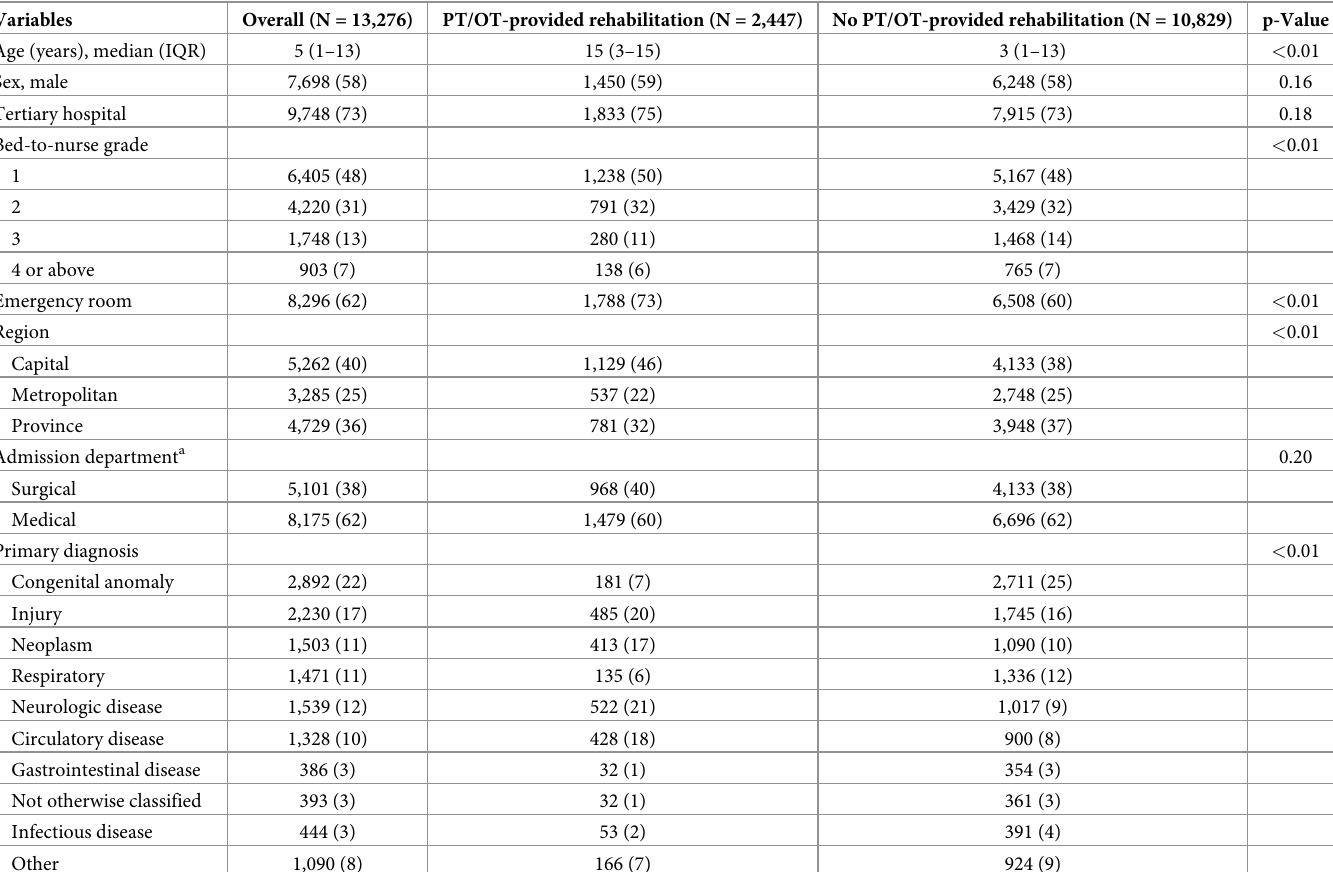
Table 1. Characteristics of ICU patients according to PT/OT-provided rehabilitation in Korea, January 2013 to July